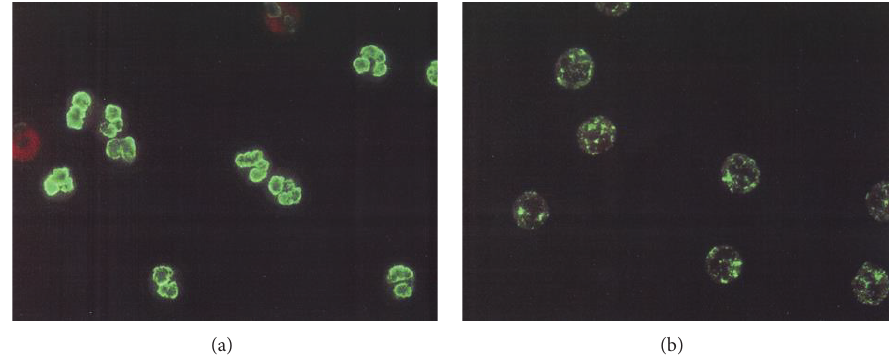
Figure 1: Indirect immunofluorescence reaction pattern of the patient’s serum. (a) Fixed with ethanol, neutrophils showed a perinuclear pattern. (b) Fixed with formalin, neutrophils showed a cytoplasmic pattern.